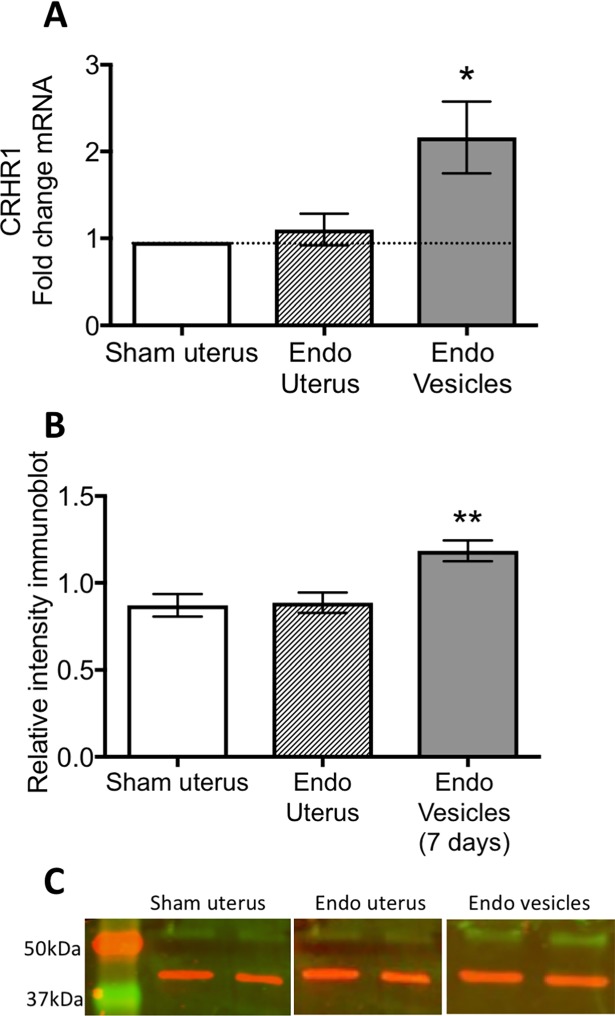
qRT-PCR and Western Blot analysis of CRHR1 within endometriosis vesicles and uterus of the endometriosis rats and sham rats.(A) At 7 days after the autotransplantation surgery to induce endometriosis, we observed a significant two-fold increase in CRHR1 mRNA within endometriosis vesicles only (n = 7 per group). (B) Western blot analysis confirmed the qRT-PCR observation showing a significant increase in CRHR1 within the endometriosis vesicles only. (C) Sample Western blot bands with the respective marker. CRHR1 was observed just above the 50 kDa marker and β-actin above the 37kDa marker. * represents p< 0.05 compared to sham group. ** represents p< 0.01 on a post-hoc analysis compared to the two other groups. Sham group n = 7, endo uterus, n = 7, endo vesicles n = 9.